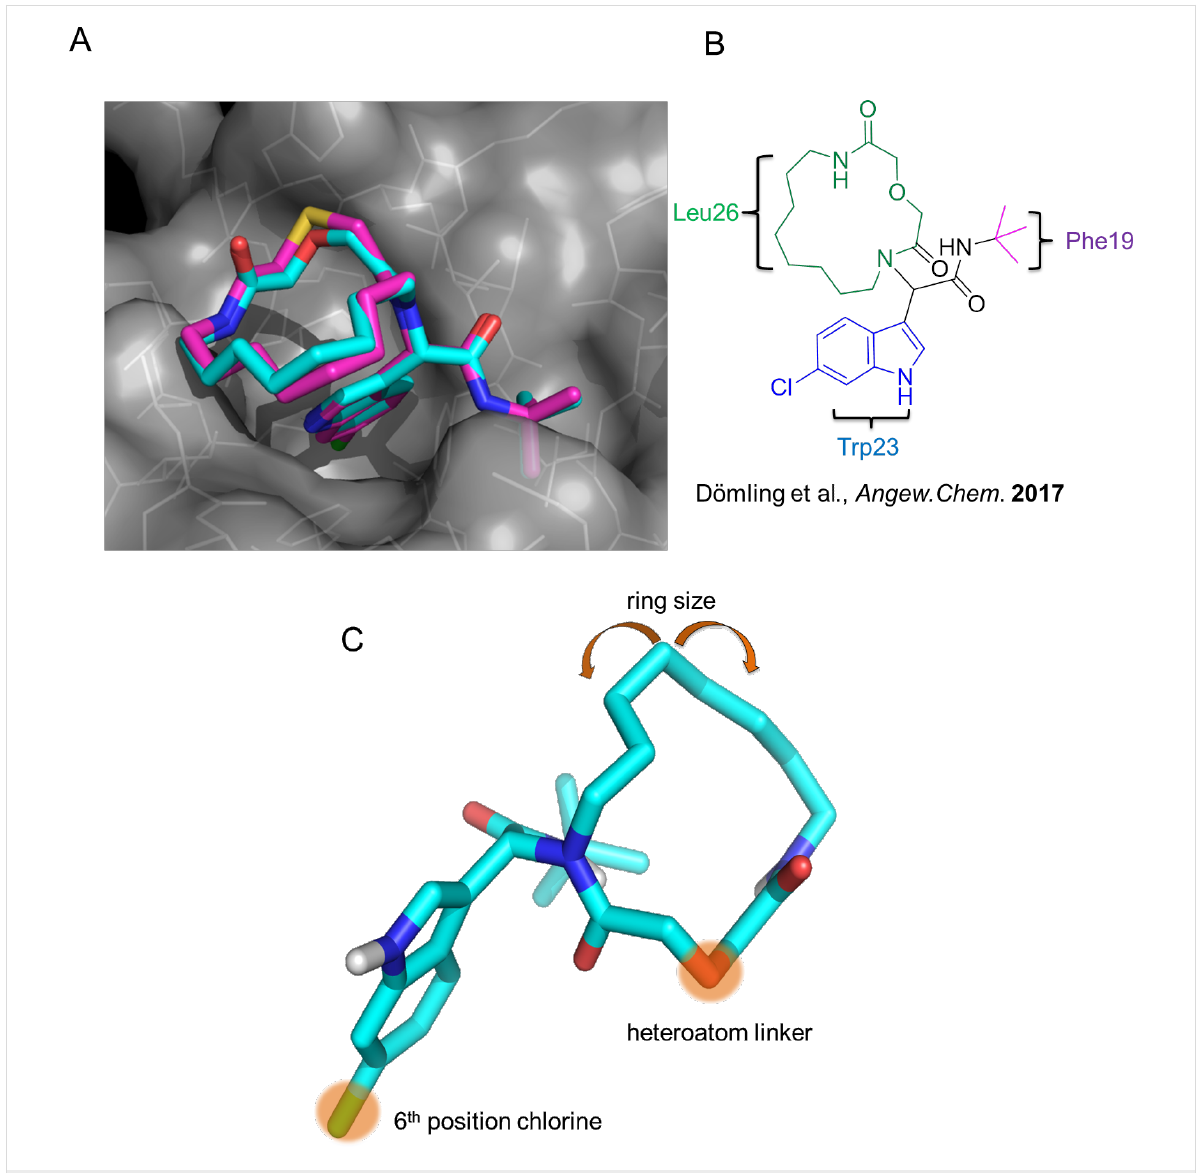
Figure 1: (A) Modeling of the macrocycle 2h (cyan sticks) and 2n (magenta sticks) into the MDM2 receptor (PDB ID: 1YCR); (B) 2D structure of 2h with the substituents targeting the subpockets of MDM2; (C) Analysis of the synthesized macrocycles probing the subpockets of MDM2 and expan- sion of the chemistry compared to previous studies